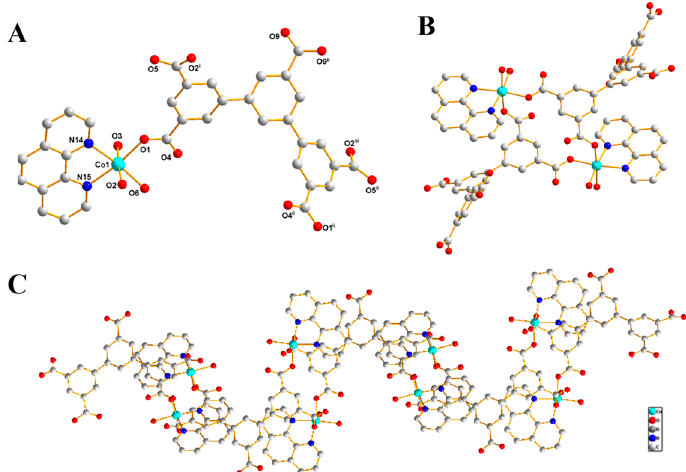
Figure 1. View of the coordination environment around Co(II) ( A ), the structure of the 16-membered ring ( B ) and the 1D chain ( C ) of 1 (Symmetry codes: (i) 1 − x , 1 − y , 1 − z ; (ii) 1.5 − x , y , 1.5 − z ; (iii) 0.5 + x , 1 − y , 0.5 + x ).